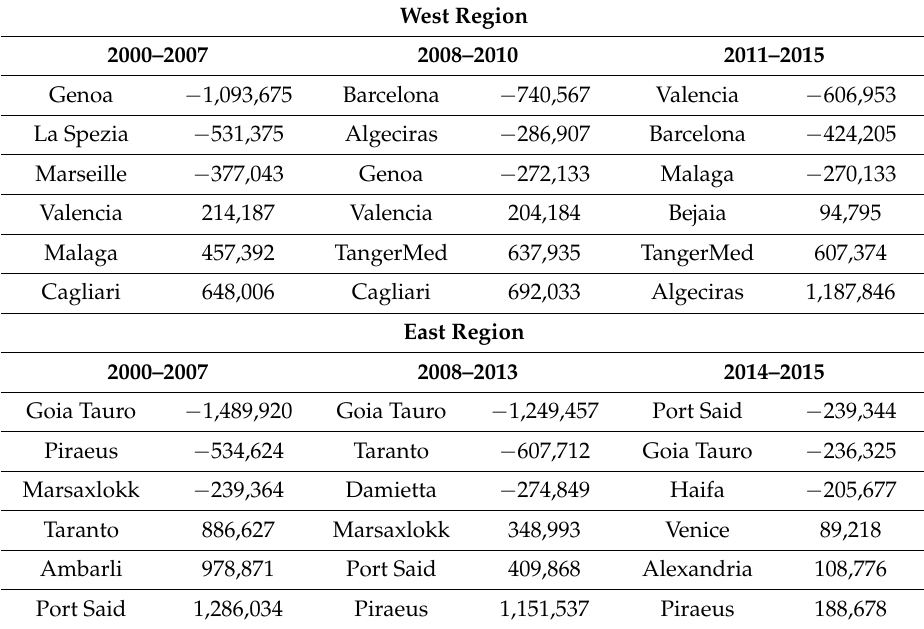
Table 2. Shift volumes (in TEU) of the top-3 lost (negative) and won (positive) for each period derived from the hierarchical clustering in function of each geographical